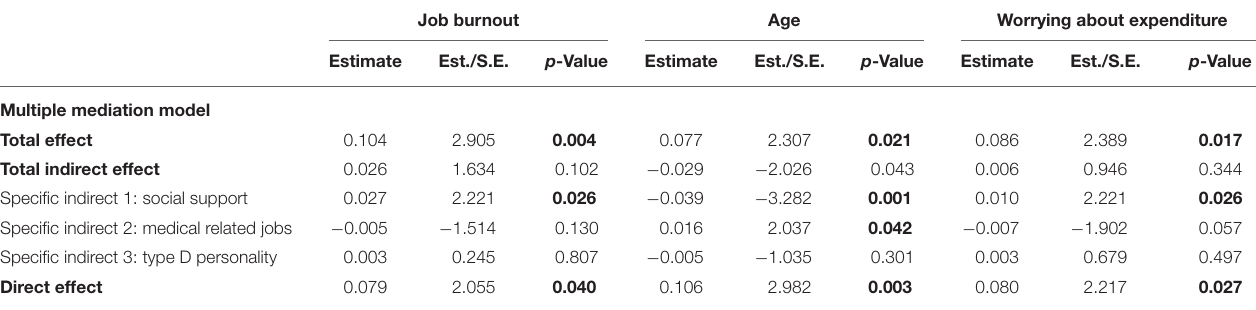
TABLE 3 | The mediation effects of relating factors between the three determinants and prehospital decision time ( N = 1,032). Job burnout Age Worrying about expenditure Estimate Est./S.E. p -Value Estimate Est./S.E. p -Value Estimate